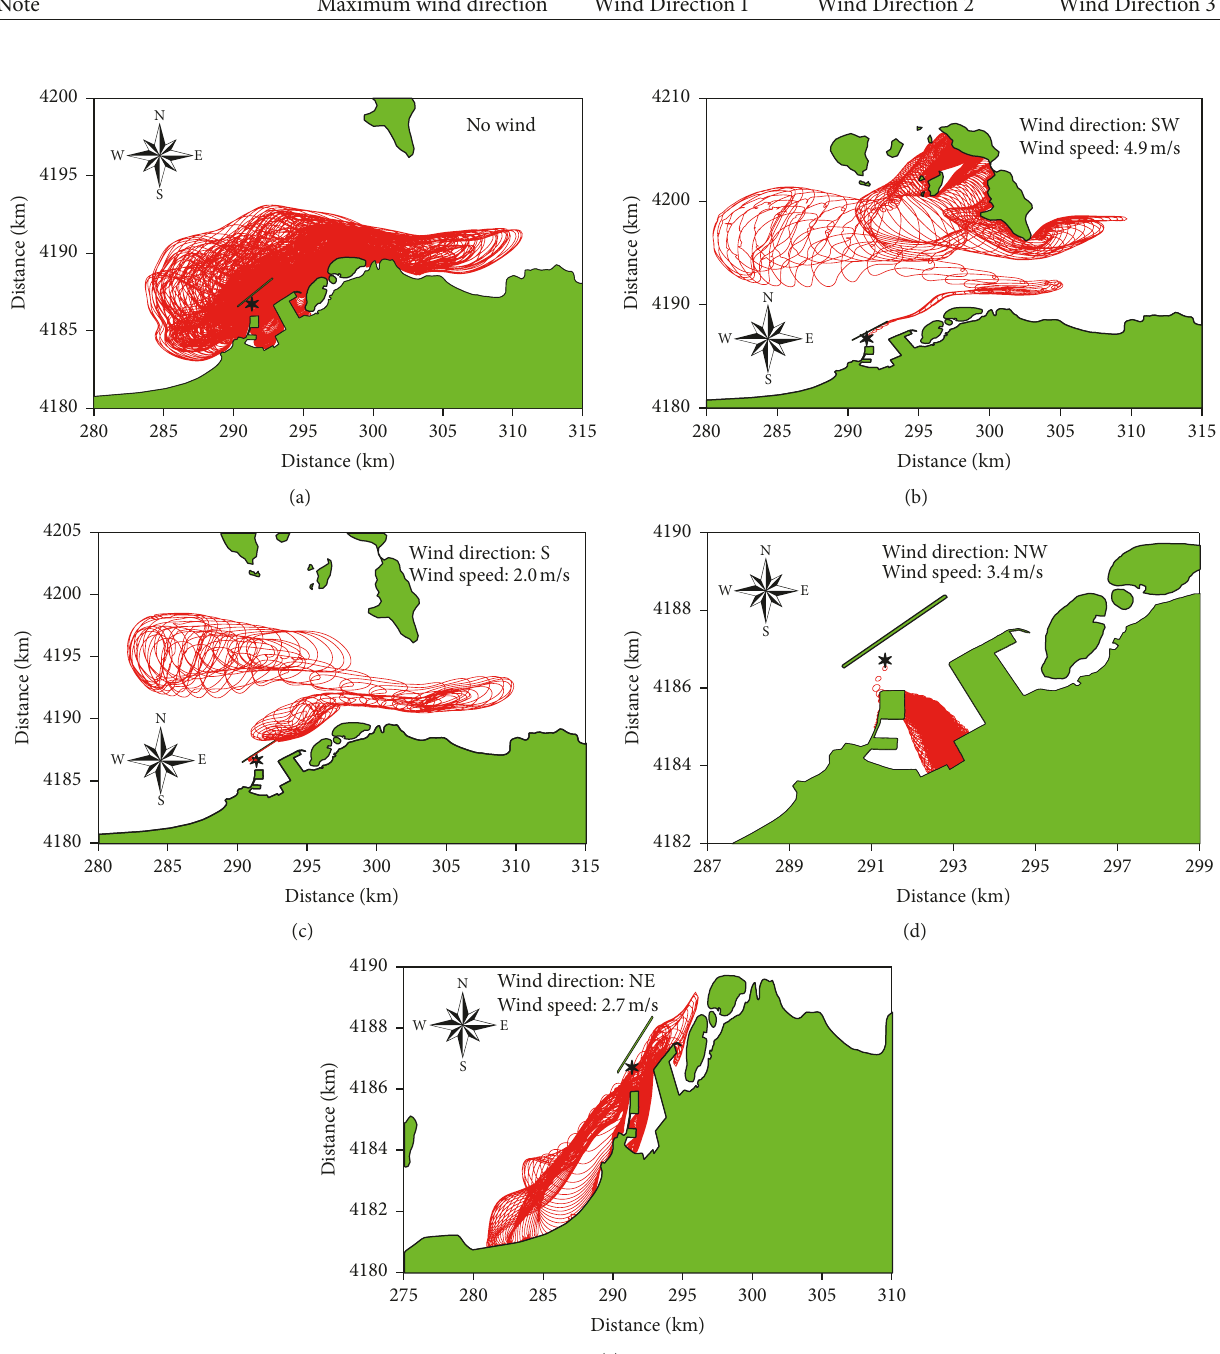
Figure 15: Trajectories of instantaneous oil spills (red line) from the western portion of the channel (black star symbol for the western spill location) under five wind conditions ((a) represents oil spill trajectory in the case of no wind, (b) represents oil spill trajectory under the influence of southwest winds, (c) represents oil spill trajectory under the influence of south winds, (d) represents oil spill trajectory under the influence of northwest winds, and (e) represents oil spill trajectory under the influence of northeast